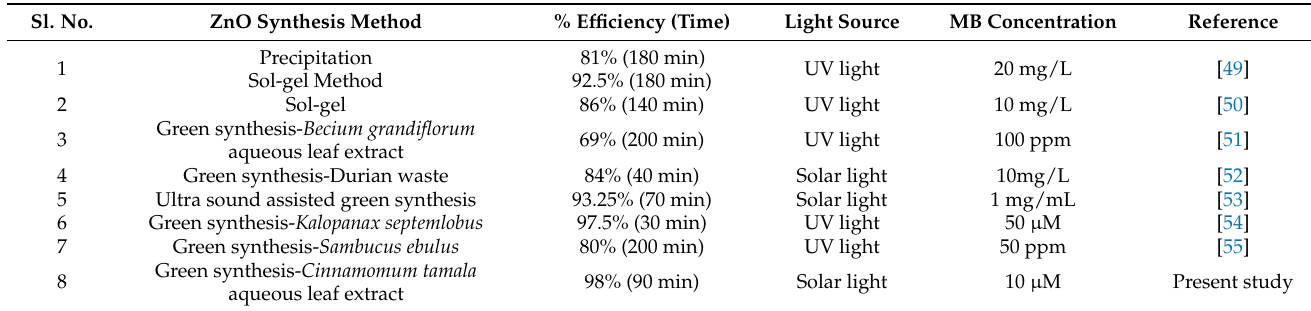
Table 3. A comparative table showing the photocatalytic efficiency of C. tamala stabilized ZnO NPs with other phtotcatalytic system based on ZnO NPs for the removal of MB. Sl.